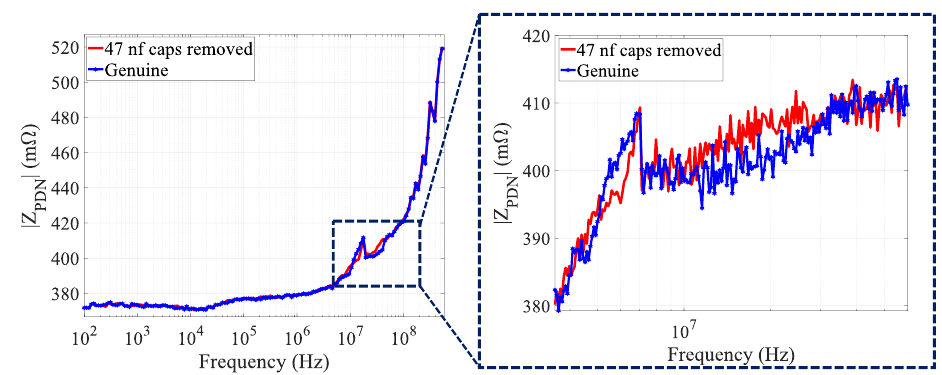
Figure 7: The mean of 105 impedance profile measurements for removing 47 nF capacitors from the board over the frequency band of 100 Hz - 588 MHz. The right-side figure shows the zoomed-in view of the bandwidth with the most deviation from the mean graph. power